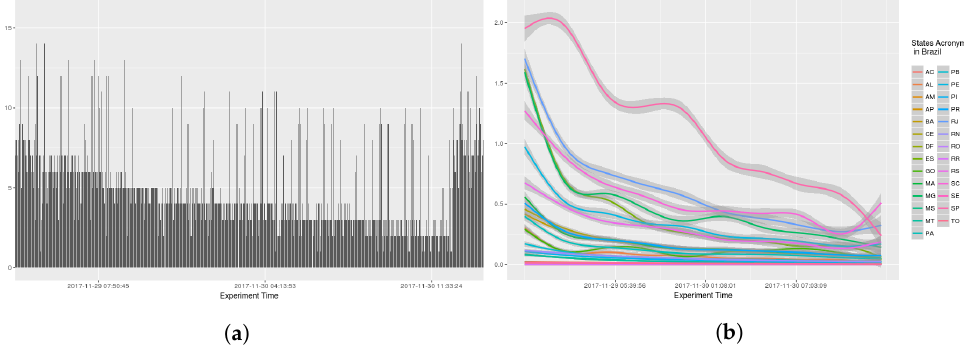
Figure 14. Scenario 01—Time Frequency. ( a ) Stations in the whole country of Brazil; ( b ) Stations grouped by states.